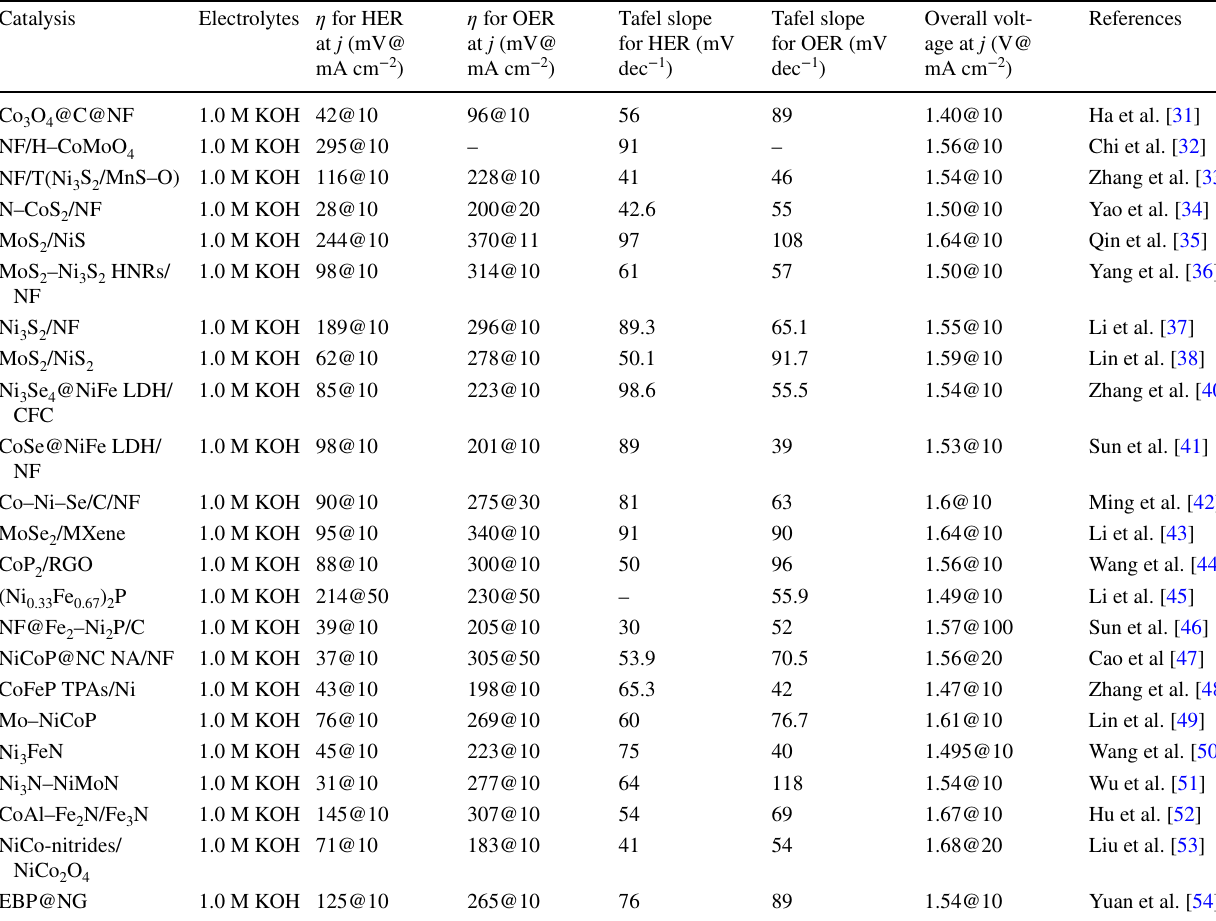
Table 1 Summary of the HER and OER activities of recently reported electrocatalysts for overall water splitting Catalysis Electrolytes ƞ for